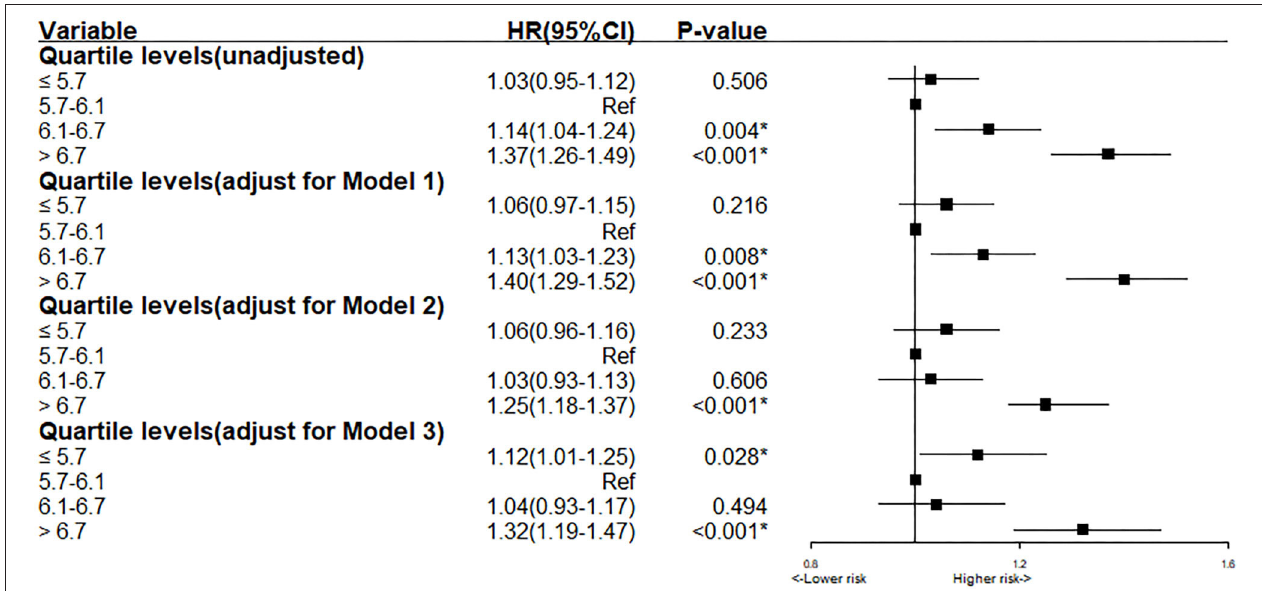
FIGURE 2 | Cox proportional hazard ratios for long-term all-cause mortality in different models. Model 1: Cox proportional hazard ratio for long-term all-cause mortality adjusted for age > 75 and gender. Model 2: Cox proportional hazard ratio for long-term all-cause mortality adjusted for eGFR. Model 3: Cox proportional hazard ratio for long-term all-cause mortality adjusted for multiple variables (age > 75, gender, AMI, HT, pre-MI, PCI, eGFR, LDLC, URIC, Statin, ACEI/ARB).